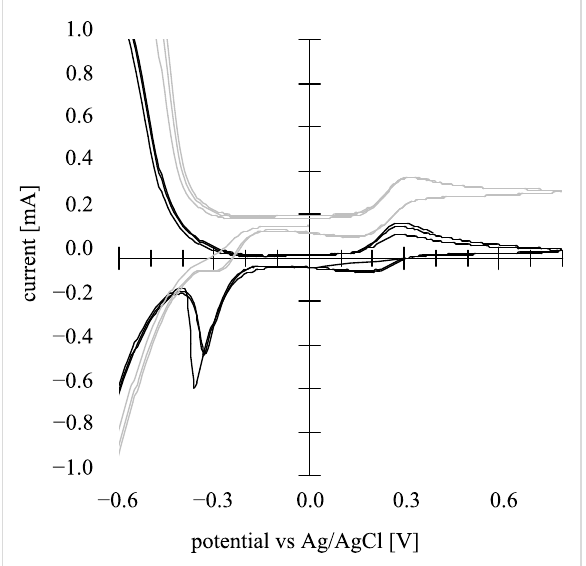
Figure 7: Cyclic voltammogram in the dark (black line) and light irradi- ation (gray line) at a nanoporous TiO 2 photoanode (1 cm × 1 cm) in a 10 wt % aqueous methanol solution containing 400 μ M [Fe(CN) 6 ] 4 − (+ 0.1 M Na 2 SO 4 , pH 8.5) under an Ar atmosphere with MEA (1 cm × 1